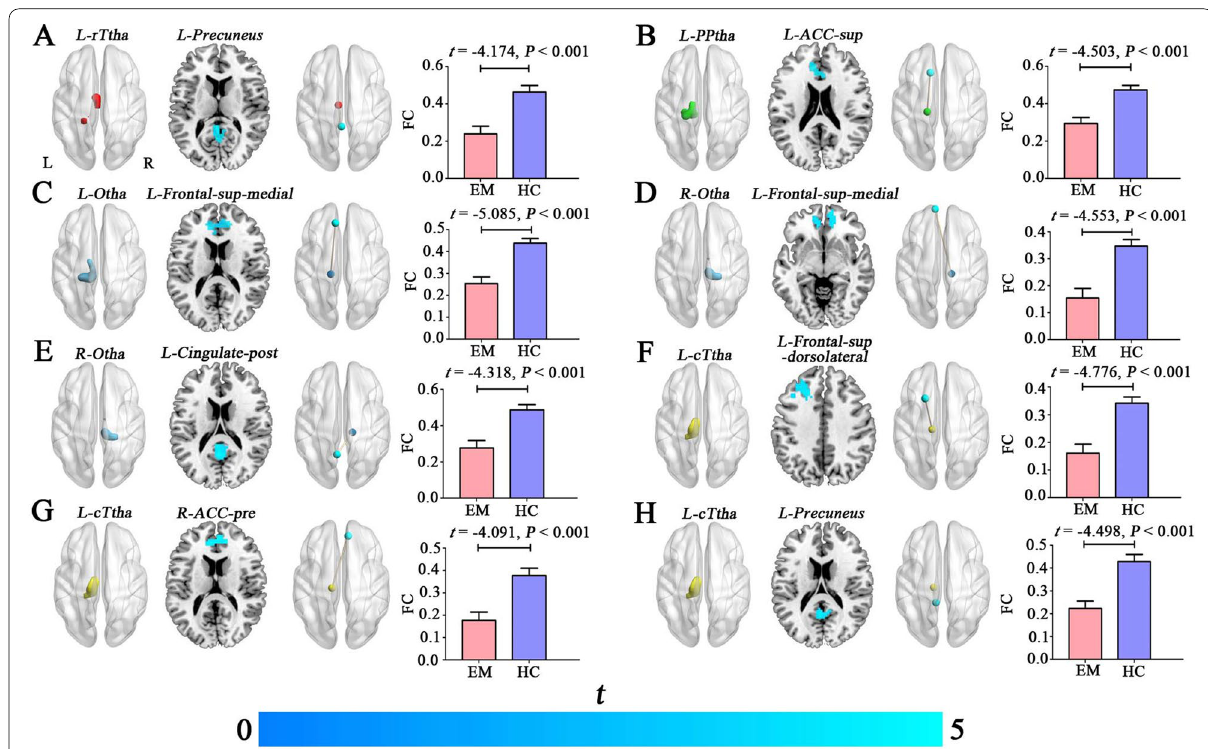
Fig. 3 Decreased rsFC of the thalamic subregions in patients with episodic migraine ( A - H ). The seed regions (L-rTtha, L-PPtha, L(R)-Otha, L-cTtha) for the voxel-based rsFC are illustrated in the first column. Brain regions (L-ACC-sup, L-Frontal-sup-medial, L-Cingulate-post, L-Frontal-sup, R-ACC-pre, L-Precuneus) showing decreased rsFC with the seed regions in patients with EM compared with HCs are shown in the second column. The functional connectivity (brown lines) between L-rTtha (red sphere) and L-precuneus (light blue sphere), between L-PPtha (light blue sphere) and L-ACC-sup (light blue sphere), between L-Otha (peacock blue sphere) and L-frontal-sup-medial (light blue sphere), between R-Otha (peacock blue sphere) and L-frontal-sup-medial (light blue sphere), between R-Otha (peacock blue sphere) and L-Cingulate-post (light blue sphere), between L-cTtha (yellow sphere) and L-frontal-sup (light blue sphere), between L-cTtha (yelllow sphere) and R-ACC-pre (light blue sphere), and between L-cTtha (yelllow sphere) and L-precuneus (light blue sphere) are shown in the third column. The fourth column represents the ROI-based rsFC analysis for the significant clusters. The error bars indicate the standard error of the mean. Abbreviations: EM, episodic migraine; HC, healthy control; FC, functional connectivity; L, left; R,